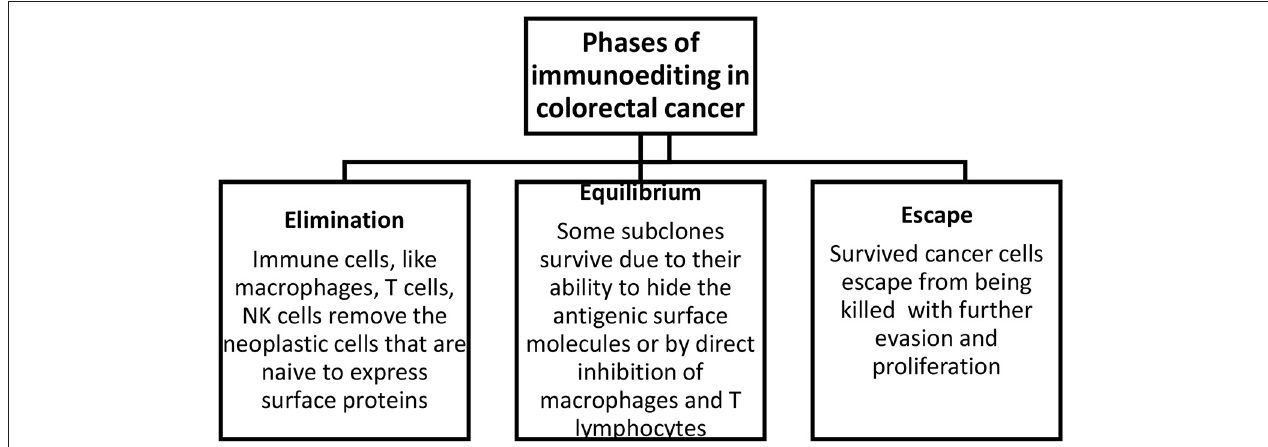
FIGURE 1 | Phases of immunoediting in colorectal cancer. Elimination includes the removal of neoplastic cells, equilibrium describes the survival of a fraction of transformed cells, and escape describes the evasion and proliferation of these